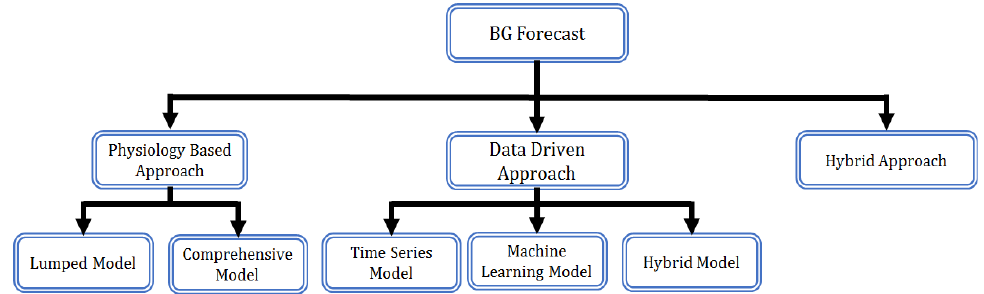
Figure 1. Blood glucose prediction approaches.